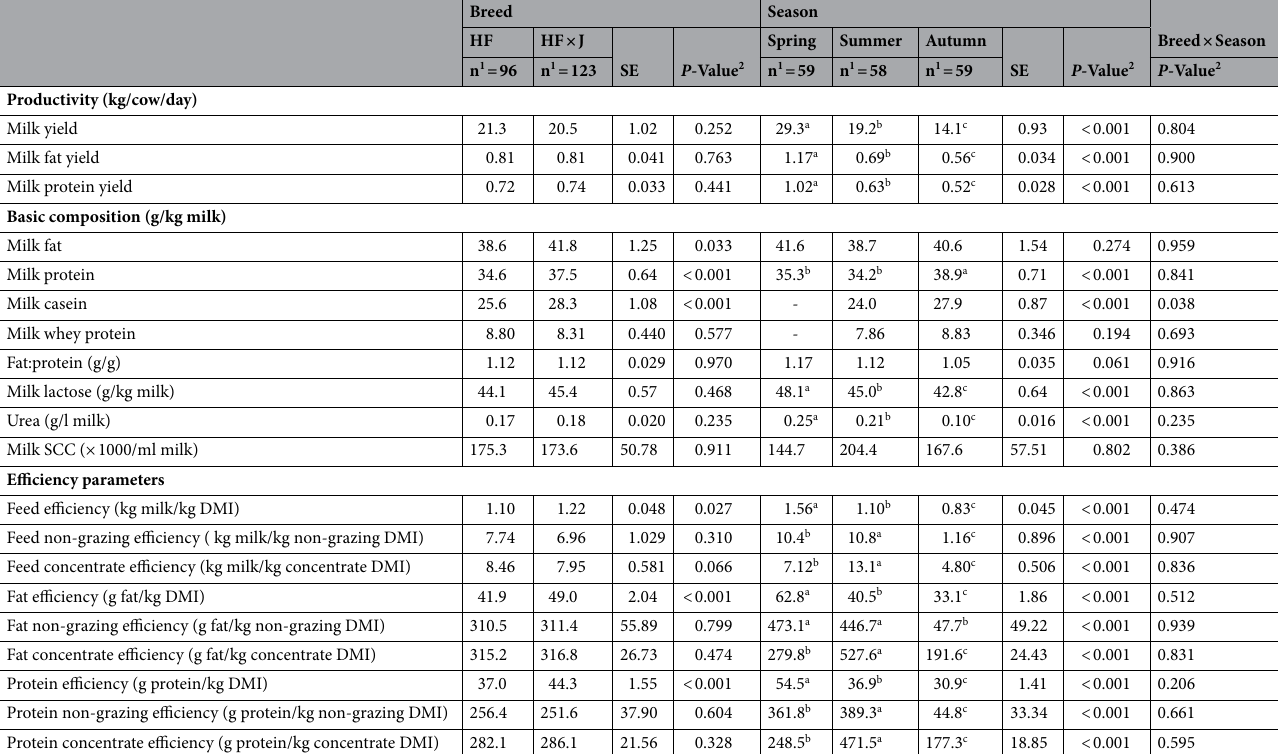
Table 2 . Means ± SE and P -values for breed and season on the yield, basic composition and efficiency parameters of milk collected from 73 individual cows from two breeding groups (100% Holstein-Friesian, HF; 50% Holstein-Friesian:50% Jersey, HF × J) and different seasons in four low-input dairy farms in England and Wales. 1 n is the number of records used to calculate means ± SE and P -values. Data for milk casein and whey protein were not collected for spring. 2 Significances were declared at P < 0.05. Means within a row, for season, with different upper-case letters are significantly different according to Fisher’s protected least significant difference test ( P <